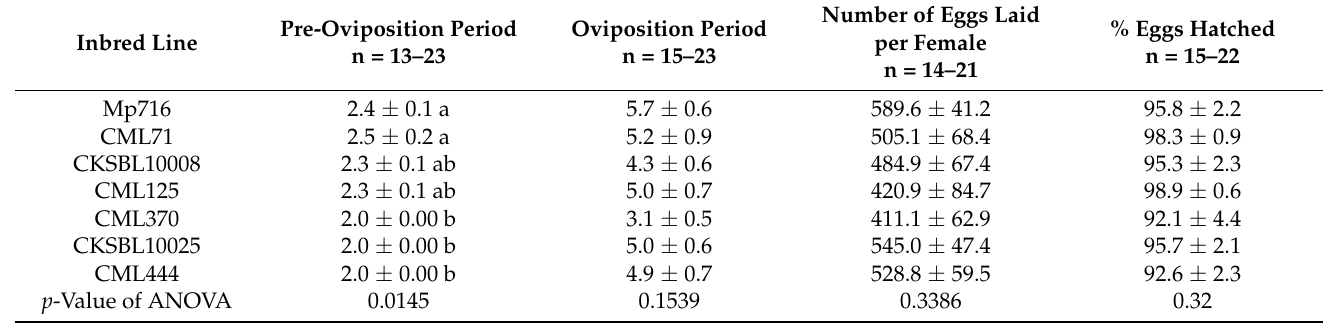
Table 2. Females’ pre-oviposition period (in days) after mating, oviposition period (in days), number of eggs laid per female and percentage of eggs hatched from larvae of Spodoptera frugiperda fed on leaf portions of different maize inbred lines under laboratory conditions. For each parameter, mean 1 ± SE are